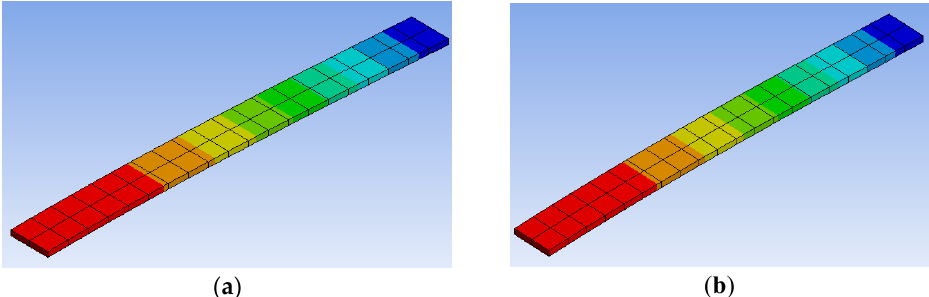
Figure 6. Deformation picture of the flat spring under the different applied forces ( a ) 4.63 N; ( b ) 1.74 N. Table 2. Comparison of the stresses and deformation results of the static stress analysis and FEA simulation.